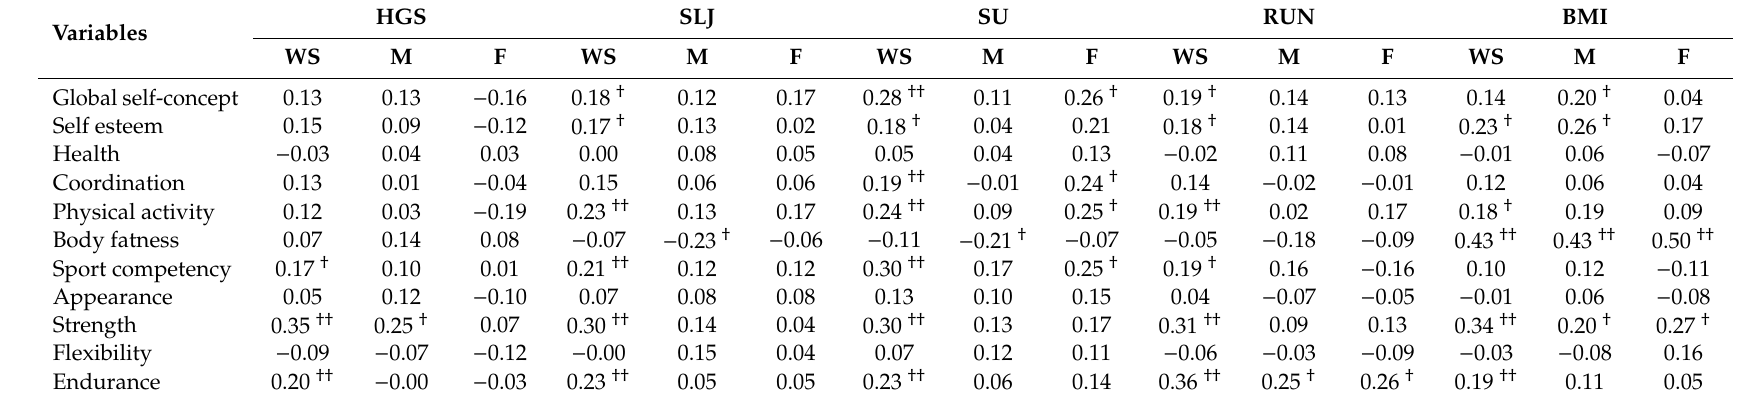
Table 4. Correlation analysis for the whole sample, male and female police